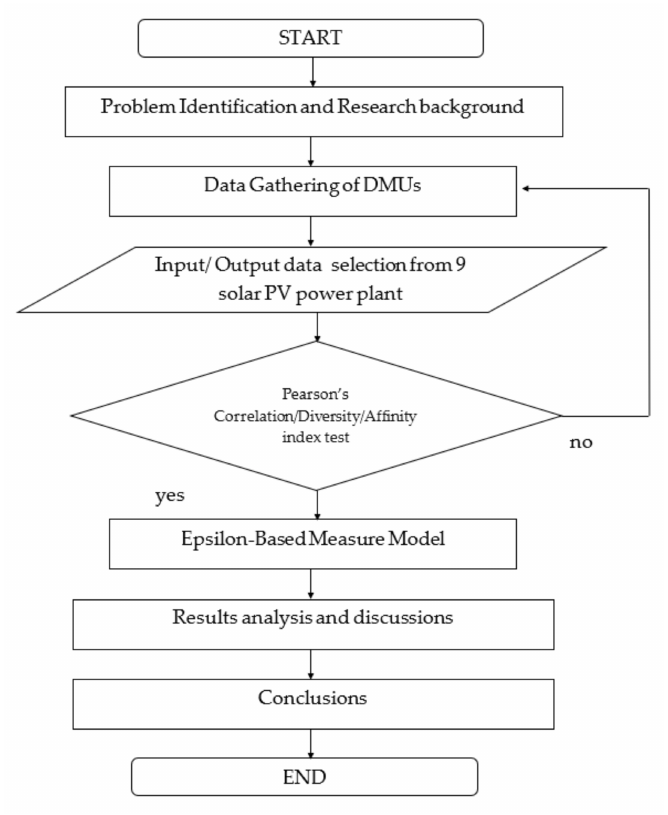
Figure 2. Flow chart of the epsilon-based measurement